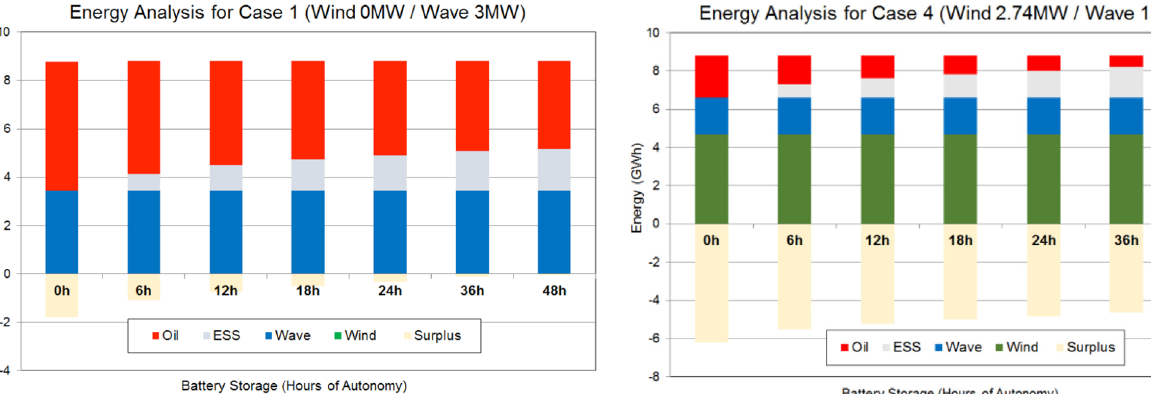
Fig. 13. Proposed solution energy analysis for case 4. Fig. 10. Proposed solution energy analysis for case 1.